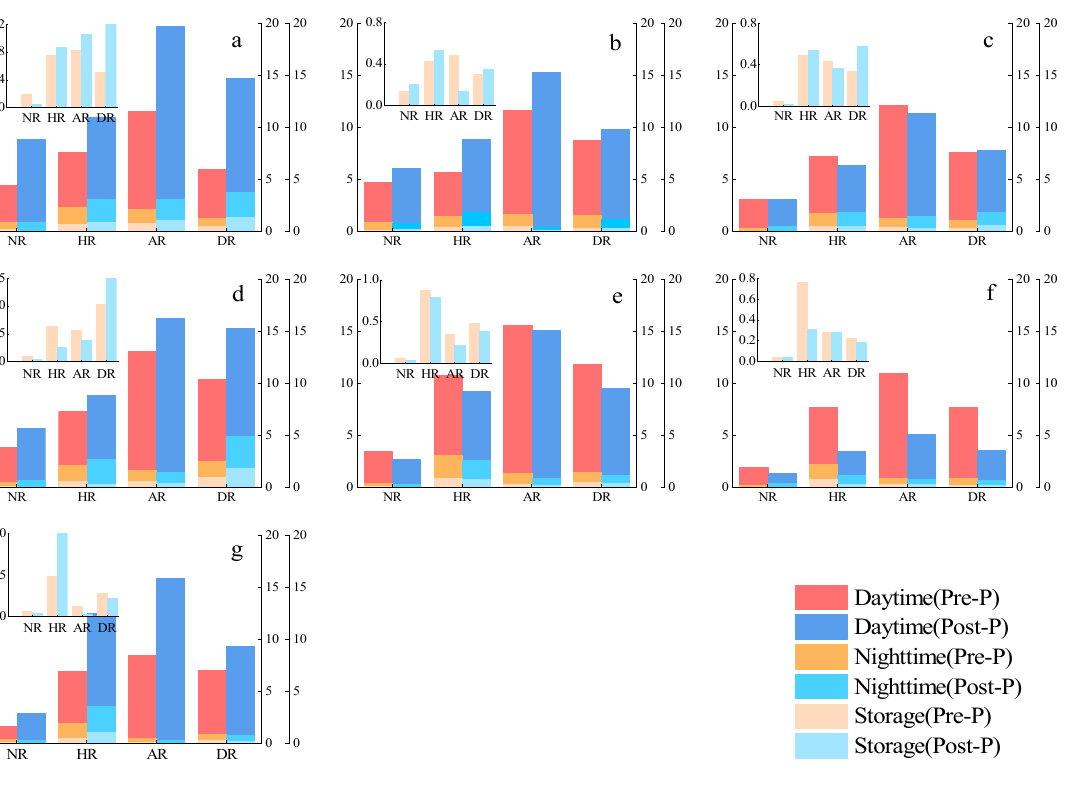
Figure 7. The average values of daytime sap flow (Q D ), nocturnal sap flow (Q N ), and water storage (Q S ) were under different treatments before and after seven precipitation events. ( a ) 8.09. ( b ) 14 August. ( c ) 19 August. ( d ) 23 August. ( e ) 4 September. ( f ) 14 September. ( g ) 19 September. The daytime sap flow (Q D ), before and after precipitation events are Daytime(Pre-P) and Daytime(Post-P); the nocturnal sap flow (Q N ) before and after precipitation events are Nighttime(Pre-P) and Nighttime(Post-P); the water storage (Q S ) before and after precipit-ation events are Storage(Pre-P) and Storage(Post - P).